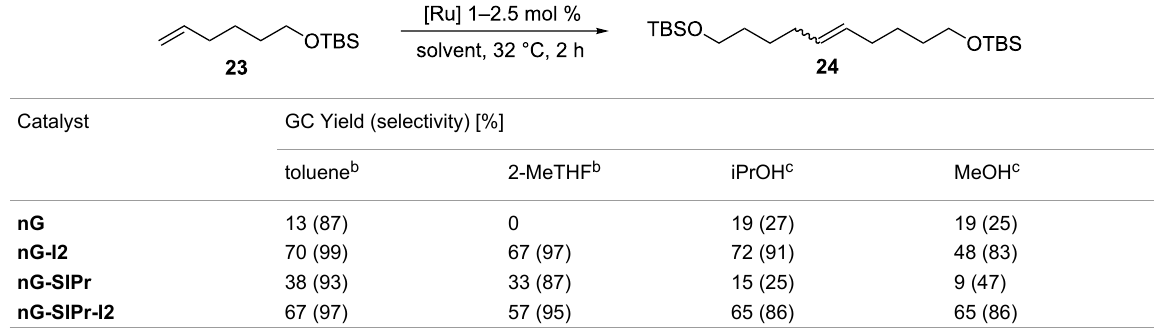
Table 5: RCM of DEDAM in ACS-grade solvents under air. a Table 6: CM of TBS protected 5-hexen-1-ol in ACS-grade solvents under air. a Catalyst